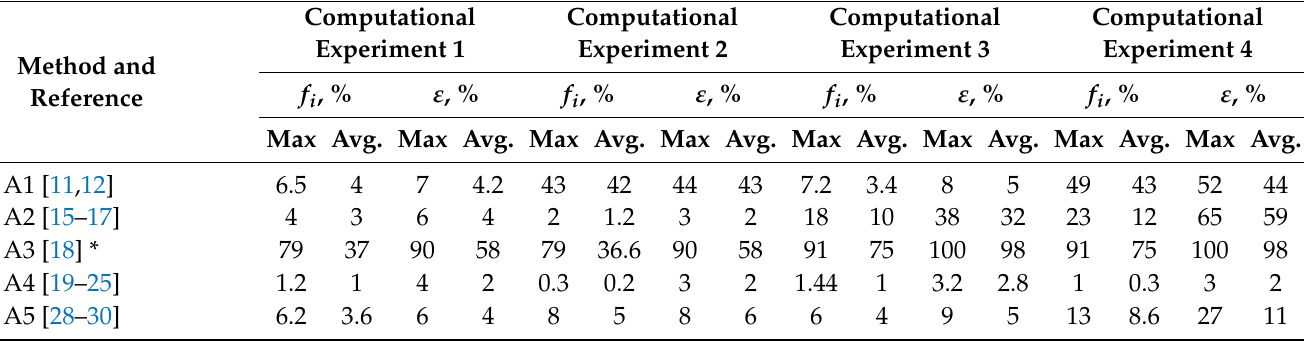
Table 2. Comparison of signal filtering methods in the saturation mode of current transformers when determining the angle and the effective value of signals according to M2.